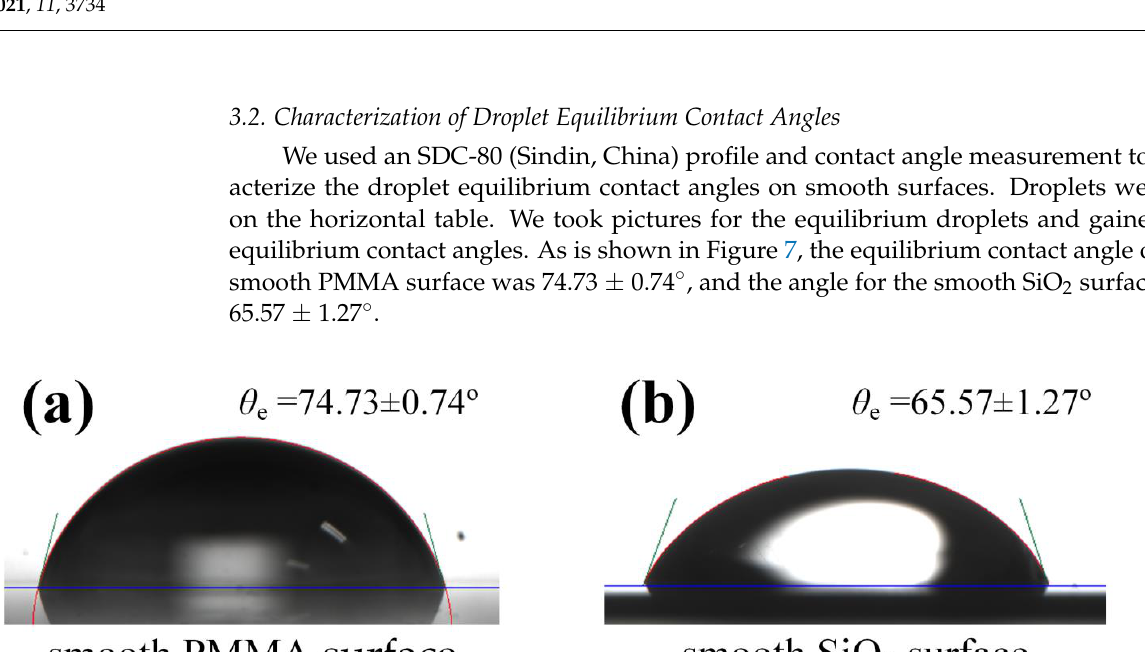
Figure 6. SEM pictures of SiO 2 rough surfaces. ( a ) The whole picture of the SiO 2 rough surface. ( b ) The periodic spacing a of the circular microstructures. ( c ) The diameter d and the height h of the circular microstructures.